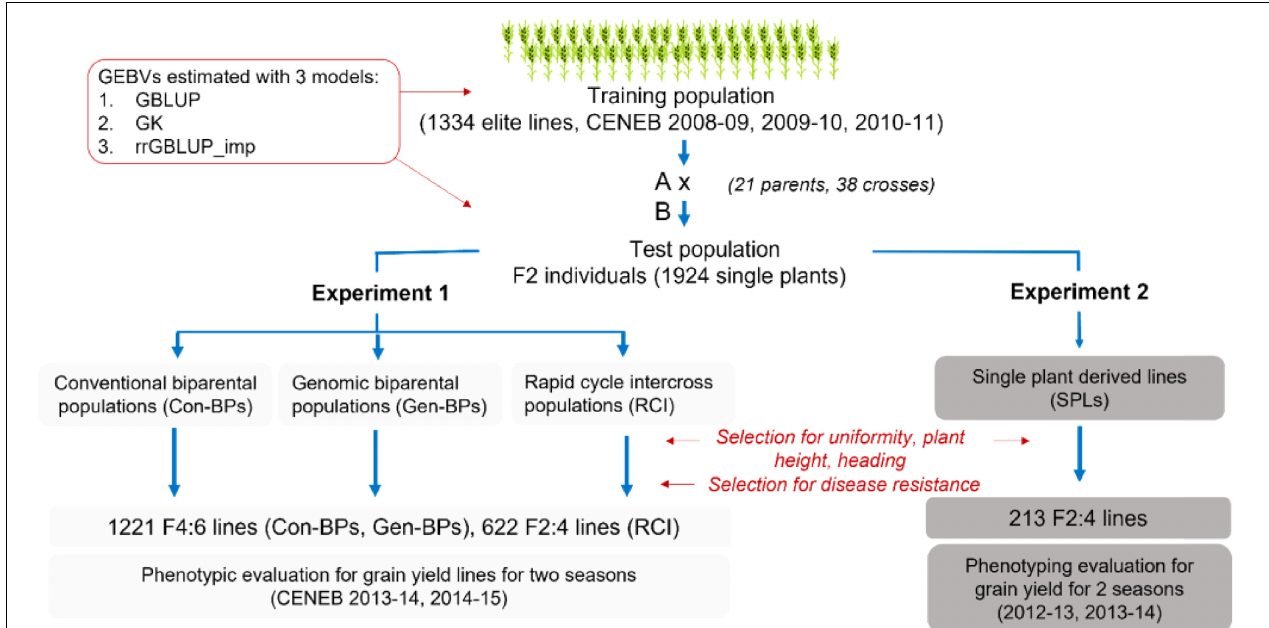
FIGURE 1 | Overview of the development of populations to validate early generation genomic prediction. Con-BPs, conventional biparental populations; Gen-BPs, genomic biparental populations; GBLUP, genomic best linear unbiased prediction; rrGBLUP, Ridge Regression BLUP; SPLs, single plant-derived lines; GK, Gaussian